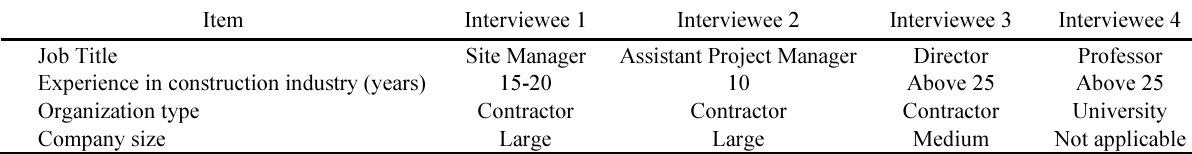
Table 4. Profile of interviewees